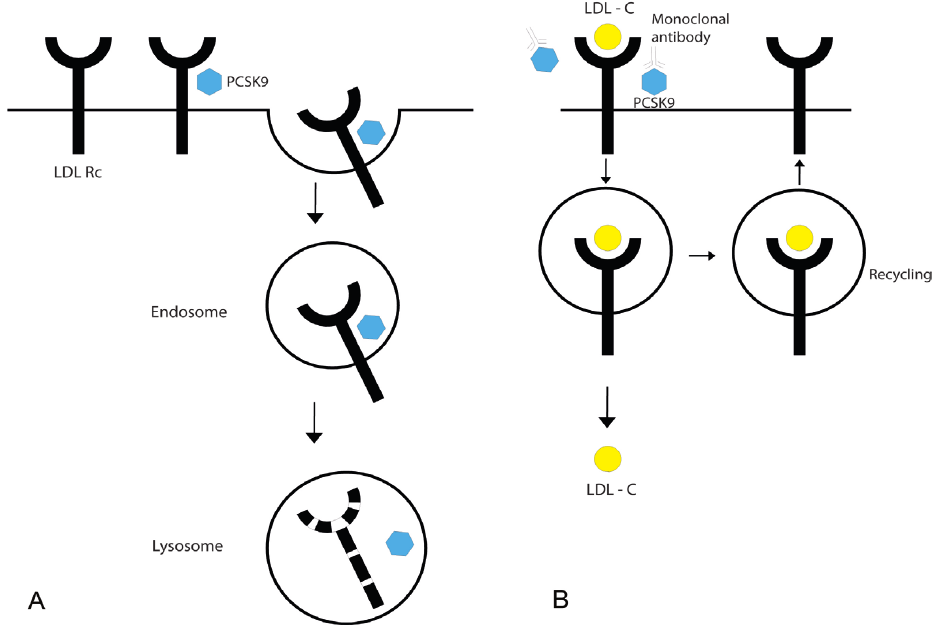
Figure 1. Effects of PCSK9 and PCSK9 monoclonal antibodies on LDL receptors. PCSK9 enzyme is secreted by hepatocytes, while LDL receptors are expressed on the surface of these cells. Upon secretion, PCSK9 binds to the extracellular region of LDL receptor. PCSK9/LDL receptor complex undergoes endocytosis and fusion with lysosomes, which results in their degradation ( A ). PCSK9 monoclonal antibodies bind circulating PCSK9 and inhibit its effect. As a result, LDL receptors remain longer on the surface of hepatocytes and undergo recycling after the internalization of LDL cholesterol ( B ). LDL Rc—LDL receptor; PCSK9—Proprotein Convertase Subtilisin/Kexin type 9; LDL-C—LDL